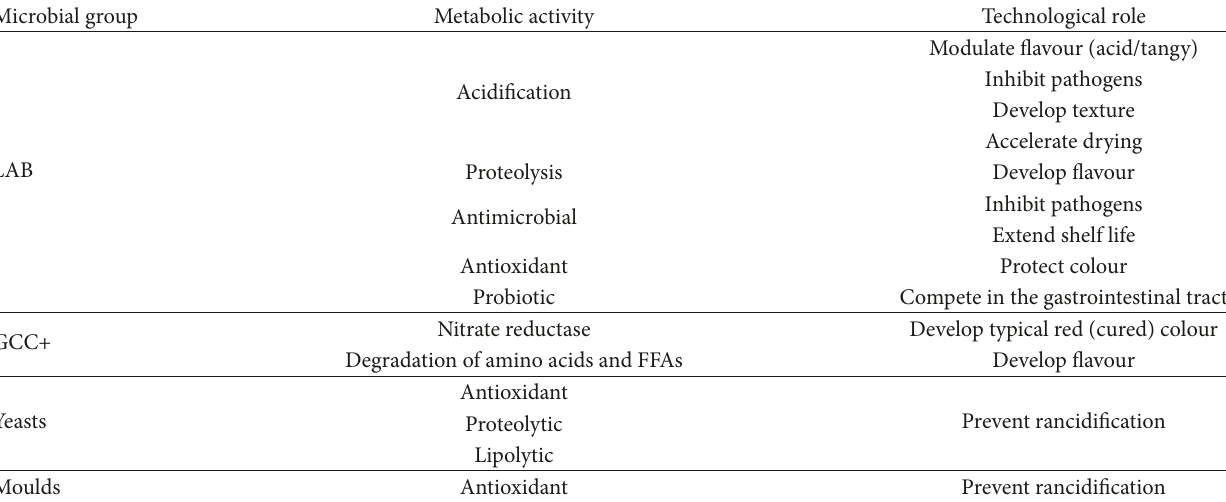
Table 5: Requirements for starter LAB, GCC+, yeasts, and